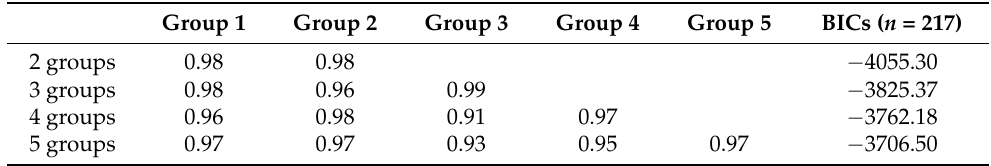
Figure 3. Group-based pain trajectories for the first 10 days after surgery. Pain trajectories for the first 10 days after the operation. 1 is the low group, accounting for 23.3%; 2 is the low-moderate-low group, accounting for 19.7%; and 3 is the high-low group, accounting for 57.0%. VAS indicates vis- ual analog scale. Fifty-seven percent of patients were in the high-low group, 23.3% were in the low group, and 19.7% were in the low to moderate-low group. The characteristics of patients in the trajectory group are summarized in Table 3. The percentage accumulation histogram between the surgery and track groups is shown in Figure 4. The following is a summary of the main demographic and clinical characteristics of each pain track group: Low: The initial pain in patients with this trajectory was mild until it exhibited a downward trend. The average age of the patients was 41.8 ± 11.7 years, and the male to female ratio was approximately 6:4. The mean BMI was 25.1 ± 3.7 kg/m 2 . The proportion of patients receiving PPH and fistulectomy is almost equal; one patient received seton therapy. Nearly half of the surgeons were chief physicians with rich clinical experience. The preoperative anxiety and pain behavior scores were 0.7 ± 0.5 and 1.9 ± 1.1, respec- tively. The total consumption of postoperative nonsteroidal analgesics was 2.2 ± 0.5 g.